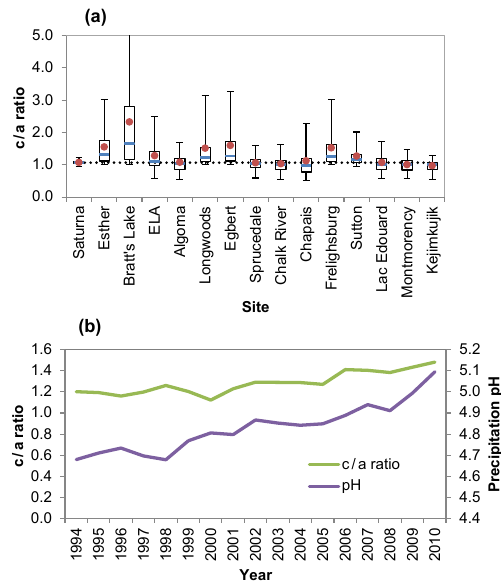
Figure 5. Geographical patterns of cation/anion (c / a) ratio (a) and temporal trends of annual average c / a ratio and precipitation pH (b) . In panel (a) , the blue line indicates the median; the red dot indicates the mean; the box and whiskers include the interquartile range and the 5th to 95th percentile range, respectively; and the dot- ted line is the overall median among the